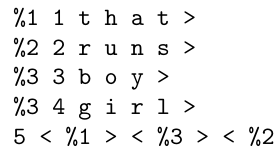
Figure 5. The best SPMA created by the SPCM between the Old SP-pattern in row 1 and the New SP-pattern in row 0.